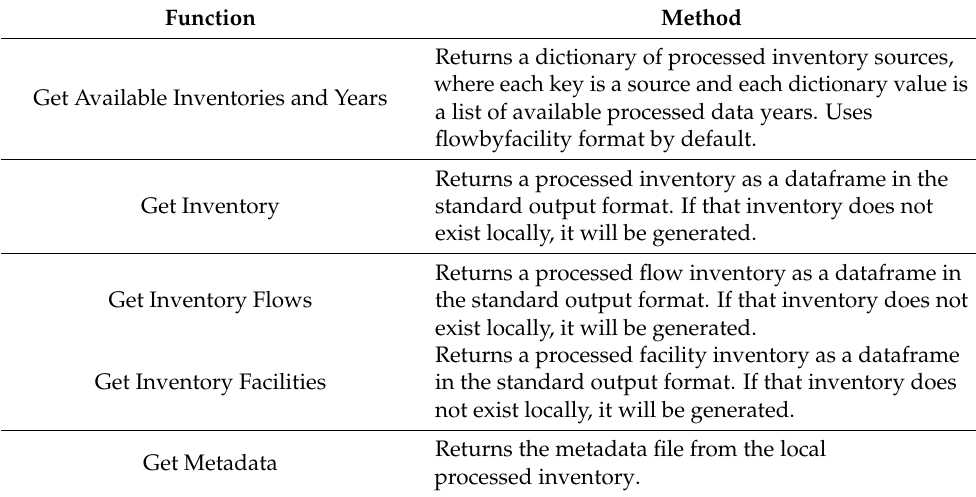
Table 1. Core stewi functions for processing and accessing inventories.